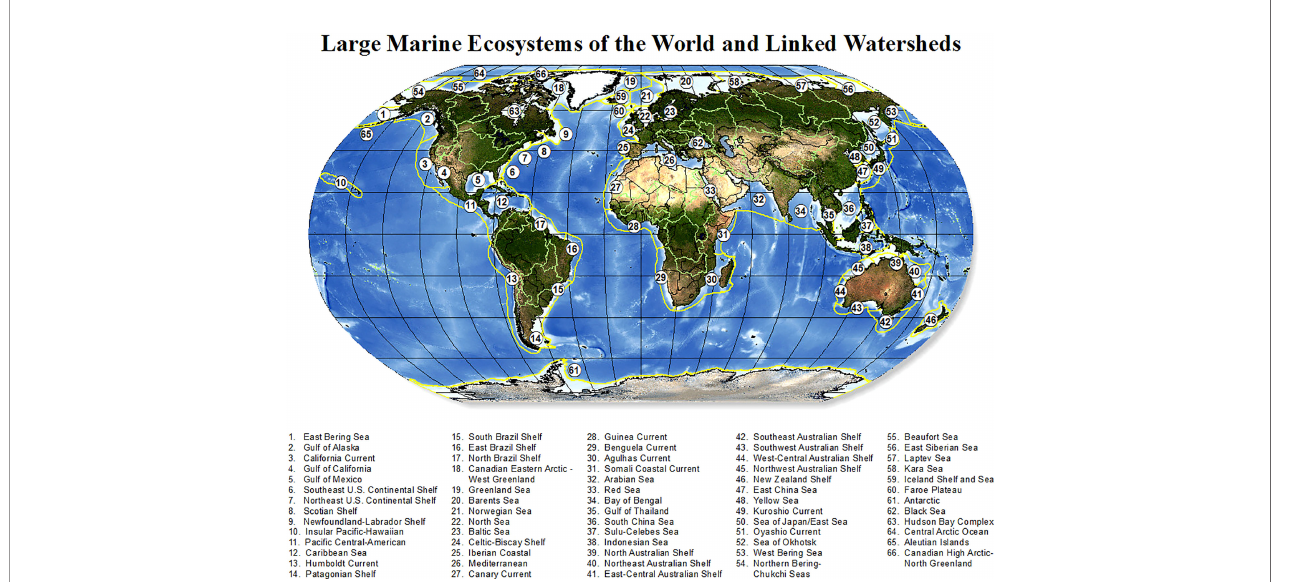
FIGURE 1 | Global map of Large Marine Ecosystems. The global ocean isdivided into 66 LMEs byOceanographers[Imagecredit,Sherman andHamukuaya